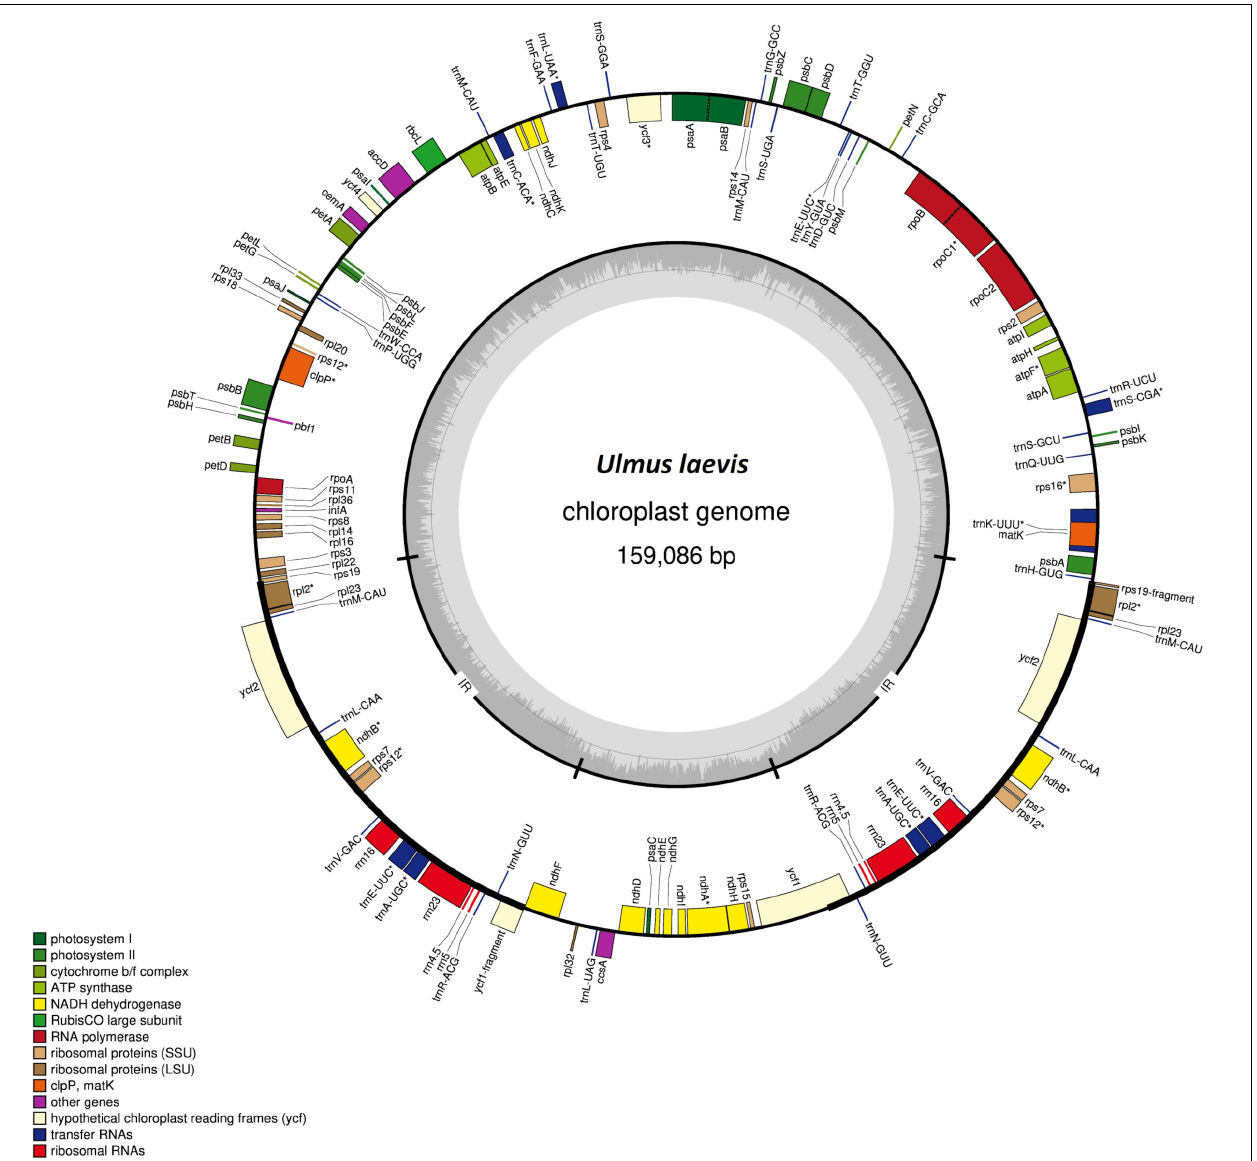
FIGURE 1 | Gene map of the Ulmus laevis chloroplast (cp) genome. Annotated genes are colored according to the functional categories. Genes lying outside of the map were transcribed in the clockwise direction, while those inside the circle were transcribed counterclockwise. Small single copy (SSC), large single copy (LSC), and inverted repeats (IRs) are indicated in the inner circle. Genes with introns are marked with an